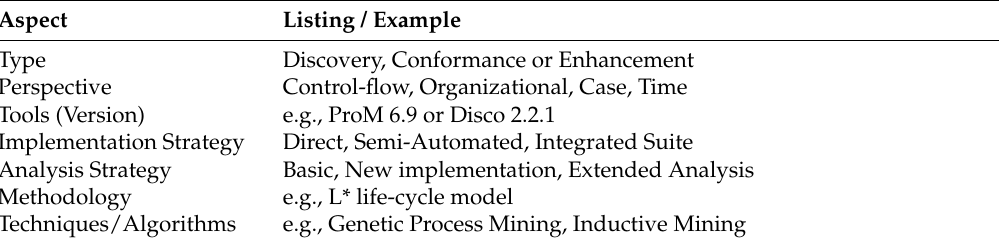
Table A3. Technical aspects about the process mining